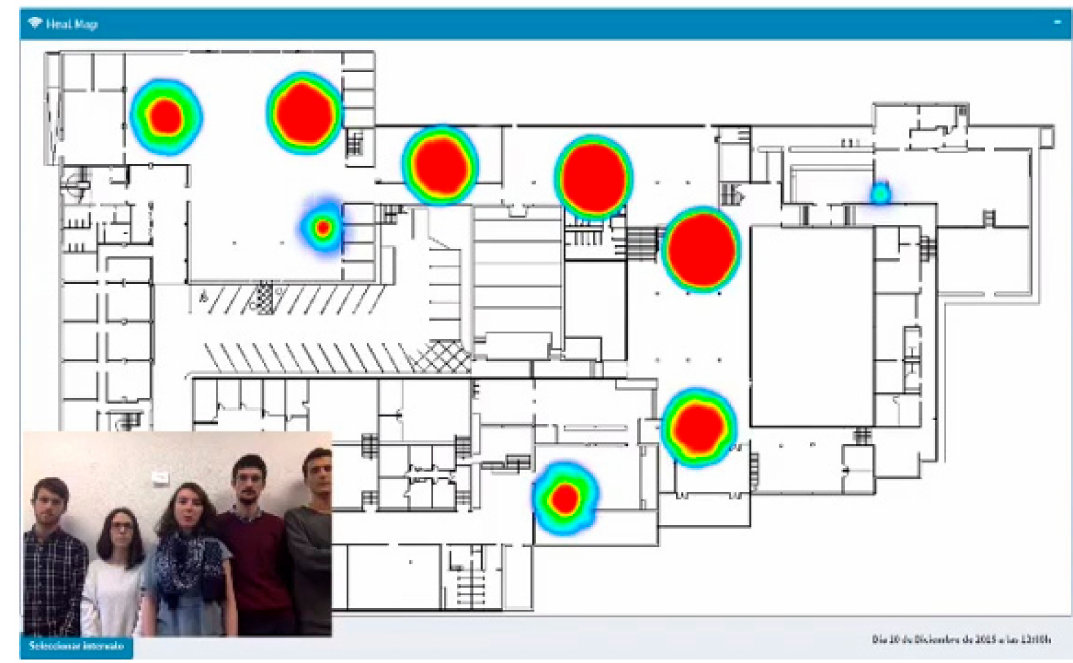
Figure 16. Smart Emergency Management web-based